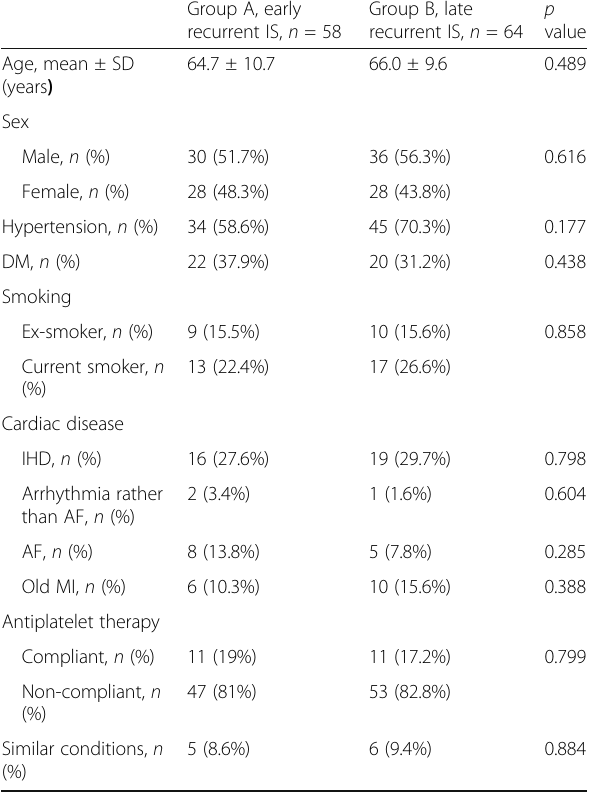
p Group A, early Group B, late recurrent IS, n = 58 recurrent IS, n = 64